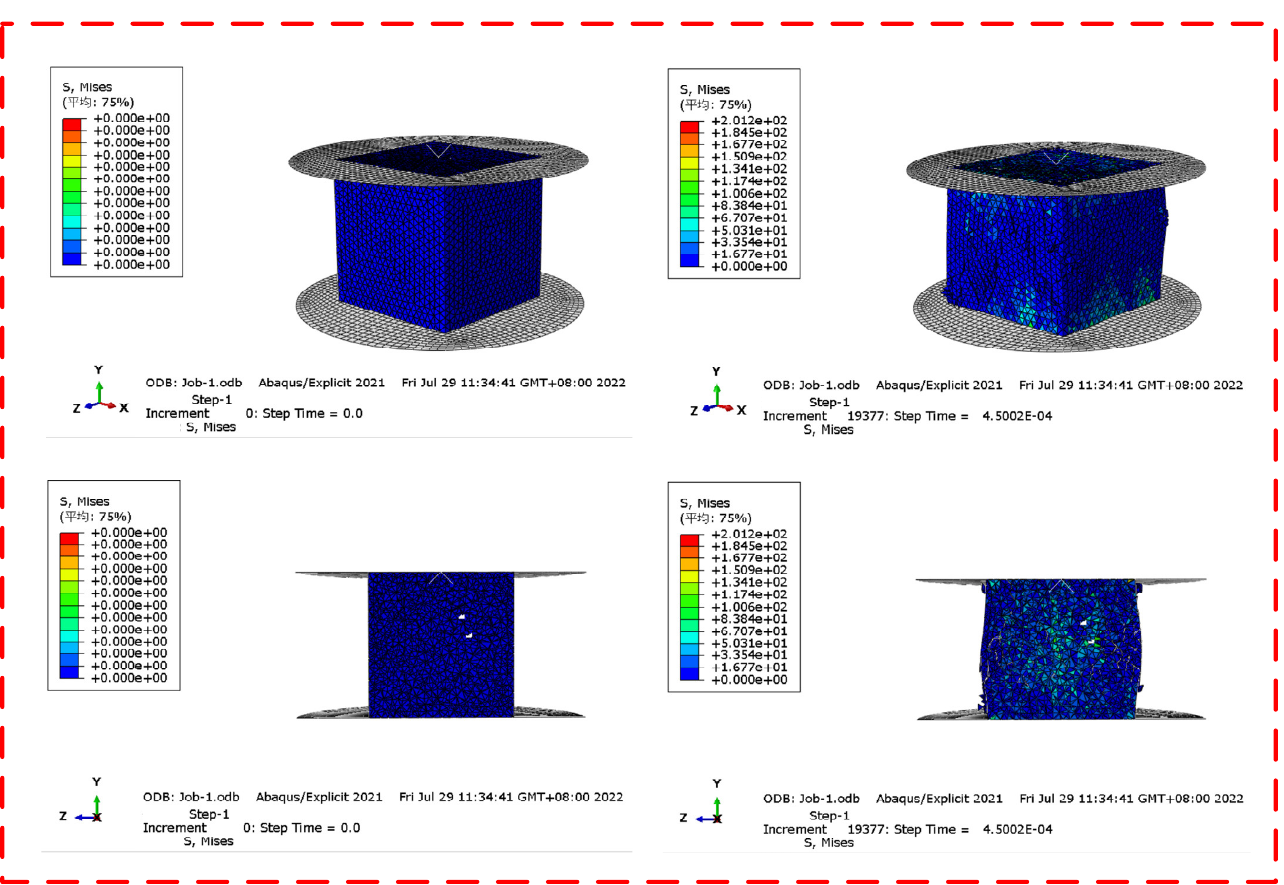
Figure 14. Stress damage cloud.